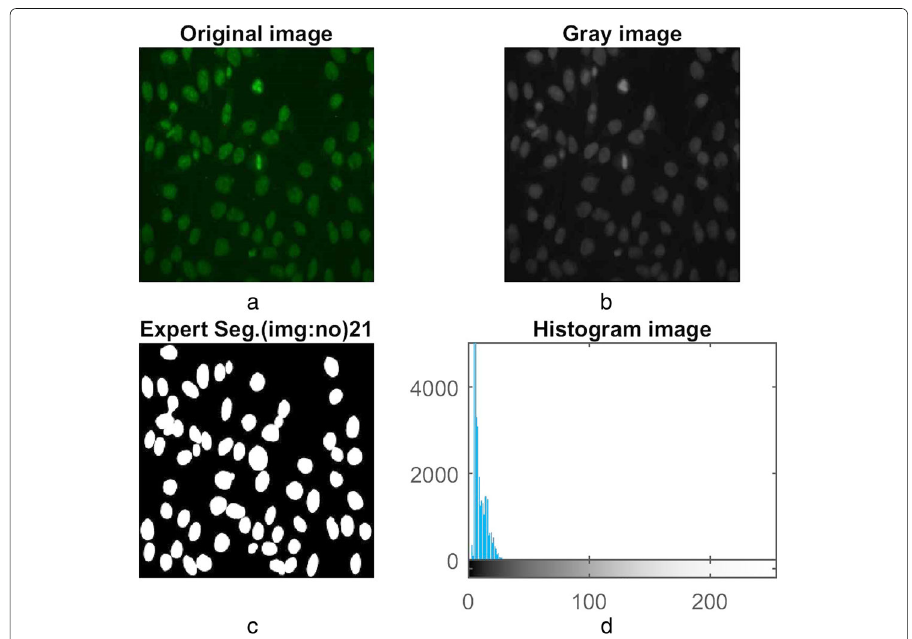
Fig. 9 a Original image. b Its gray level. c Expert segmentation. d Image histogram